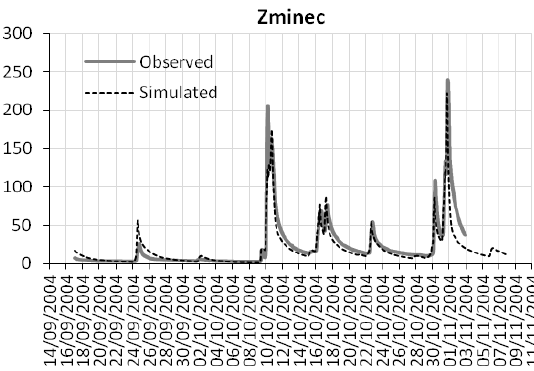
Fig. 5a. Model results for the validation period, 17/09/2004 to 08/11/2004. Figure 5a: Model results for the validation period, 17/09/2004 to 08/11/2004. 5